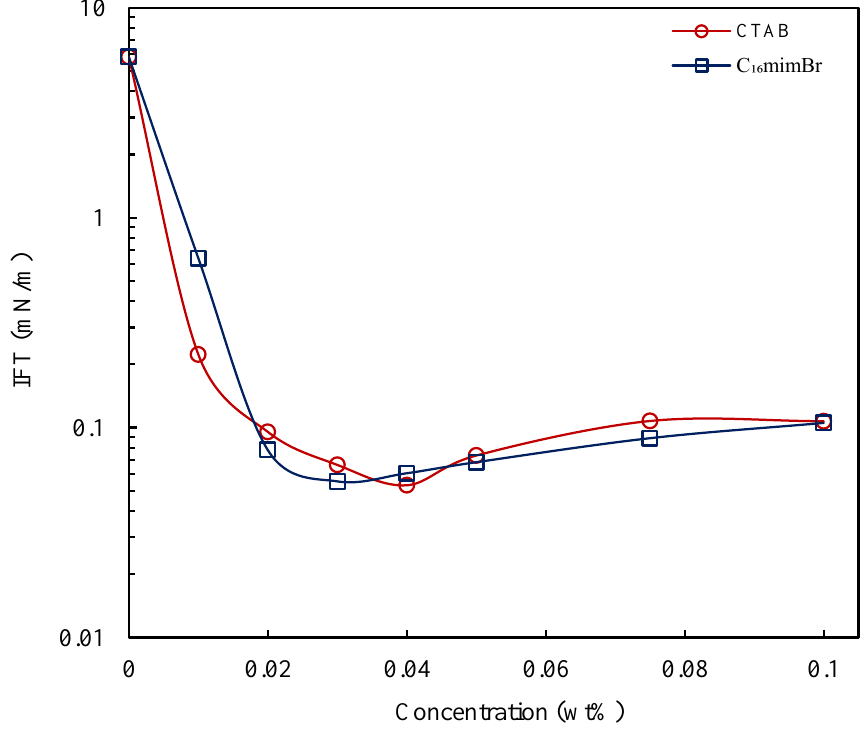
Figure 7. Aqueous–crude oil IFT variation with the surfactant concentration at 25 ◦ Figure 7. Aqueous – crude oil IFT variation with the surfactant concentration at 25 °C.